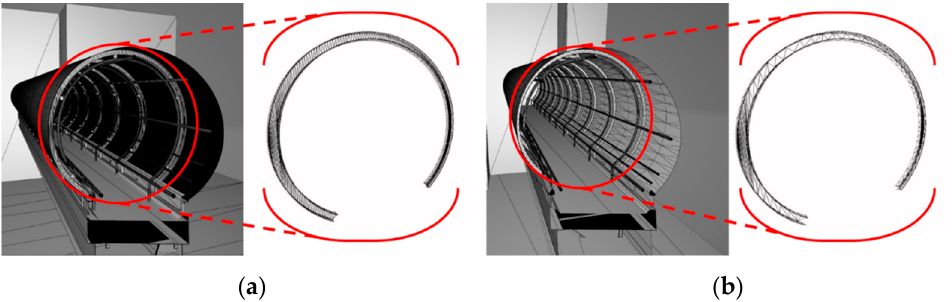
Figure 7. SKKU steel bridge models and internal glass structure (mesh-form): ( a ) original and ( b ) optimized. Table 1. SKKU steel bridge original and optimized